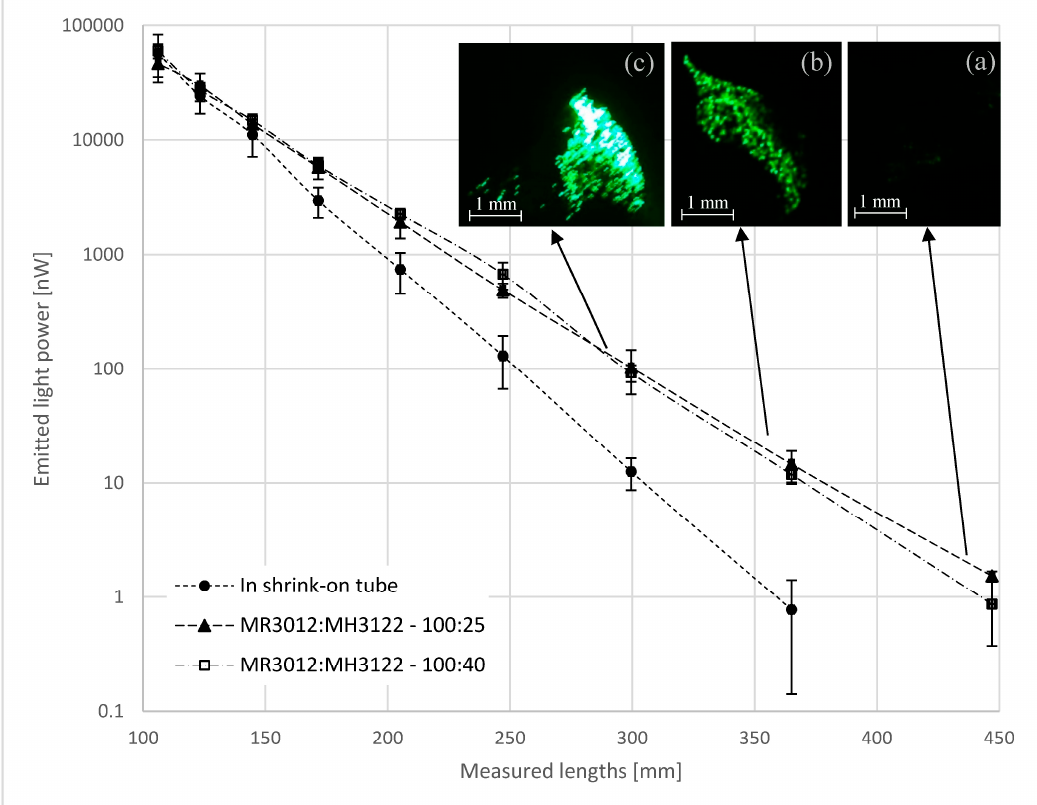
Figure 4. The light power emitted from the reinforcing glass fiber bundles at room temperature. The wavelength of the light was 532 nm. The bundles were in shrink-on tubes or in the MR3012:MH3122 resin (weight ratios of 100:40 or 100:25). The images of the emitted light were recorded with a USB microscope camera at a length of ( a ) 447 mm; ( b ) 365 mm; and ( c ) 300 mm.